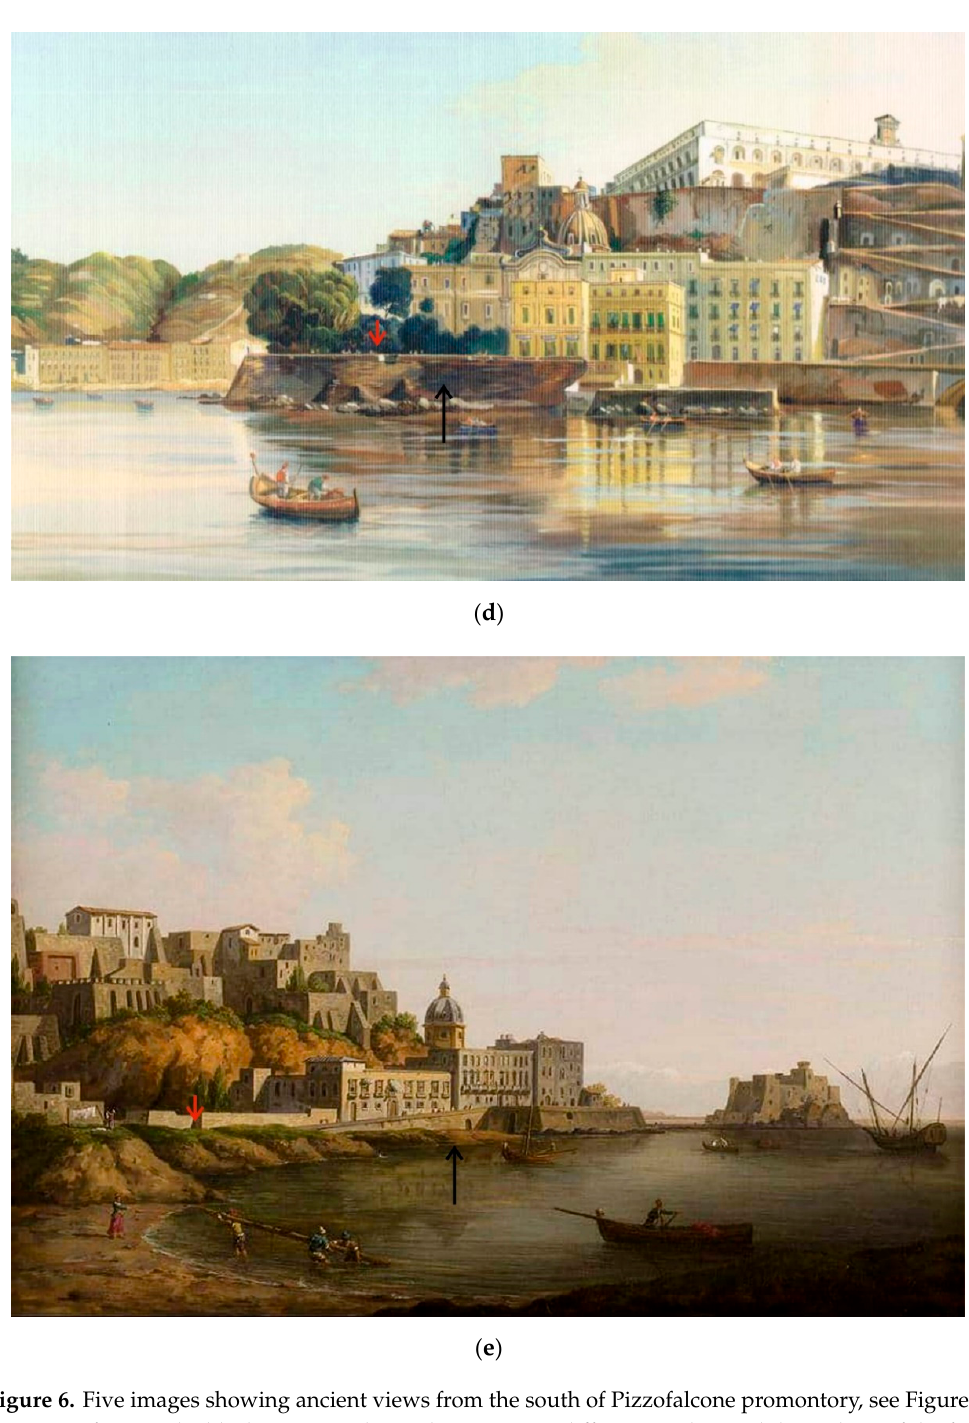
Figure 6. Five images showing ancient views from the south of Pizzofalcone promontory, see Figure 5 for point of view. The black arrows indicate the active sea cliff in NYT, detected downslope of the first order platform (red arrows). ( a ) Painting by Consalvo Carelli 1836, view from SW; ( b ) 1800’ photo, view from SW; ( c ) 1800’ photo, view from SE; ( d ) painting by Anton Sminck Pitloo 1820, view from S; and, ( e ) painting by William Marlow 1790, view from SW.